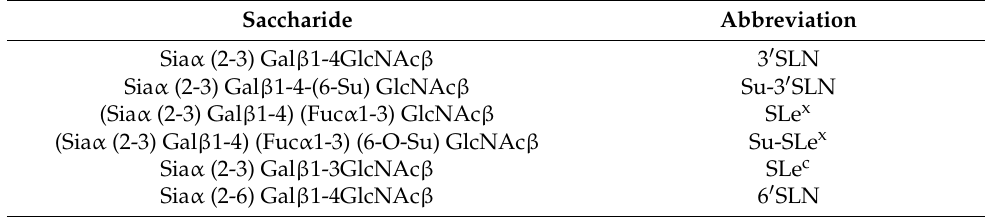
Table 2. Structures of oligosaccharides used in this study.